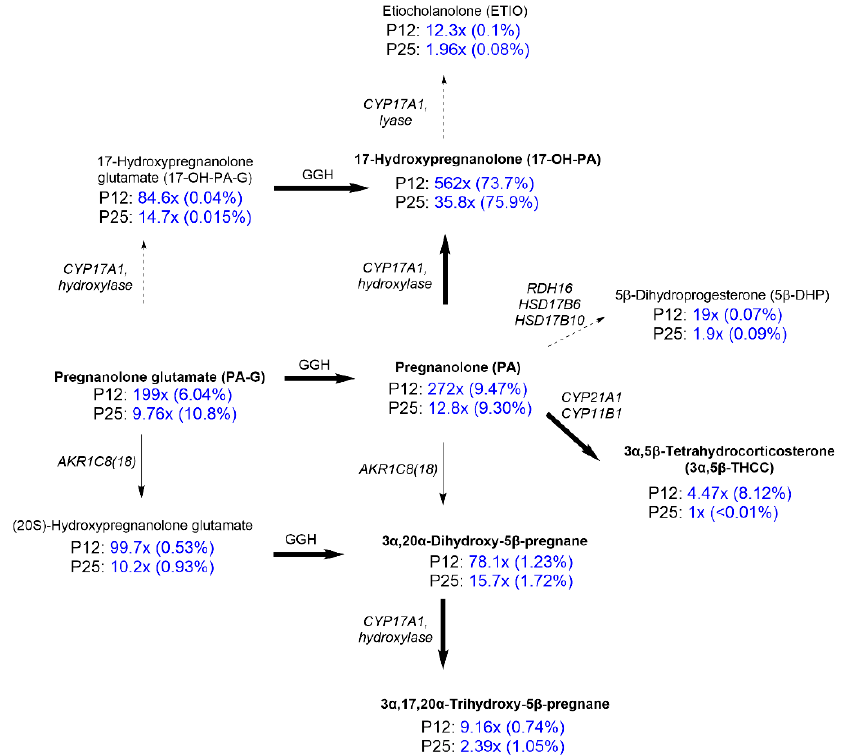
Figure 5. Steroidal metabolites identified in the hippocampus of male Wistar rats (P12 and P25 days old) after the administration of PA-G (i.p., 1 mg/kg in CDX). Only the steroids with significant in- creases above the basal levels (before PA-G application) are shown. The bold solid, thin solid, and thin dashed arrows indicate high, medium, and low conversion, respectively. The values below the name of the steroid compound represent the fold increase in the concentration of that particular compound and the percentage of total significantly increased steroids (in parenthesis) in the rat hippocampus above the basal levels 20 min after PA-G application. The names of steroids exceeding 1% of the total significantly increased 5 β steroids are highlighted in bold. The abbreviations in italics represent steroidogenic enzymes in rats. AKR1C8(18): Type 8(18), subfamily 1C aldo-ketoreductase, CYP11B1: steroid 11 β -hydroxylase; CYP17A1: steroid 17-hydroxylase-C17,20-lyase; CYP21A1: ster- oid 21-hydroxylase; GGH: γ -glutamyl hydrolase; HSD17B6: steroid type 6 17 β -hydroxysteroid de- hydrogenase; RDH16: Type 16 retinol dehydrogenase.